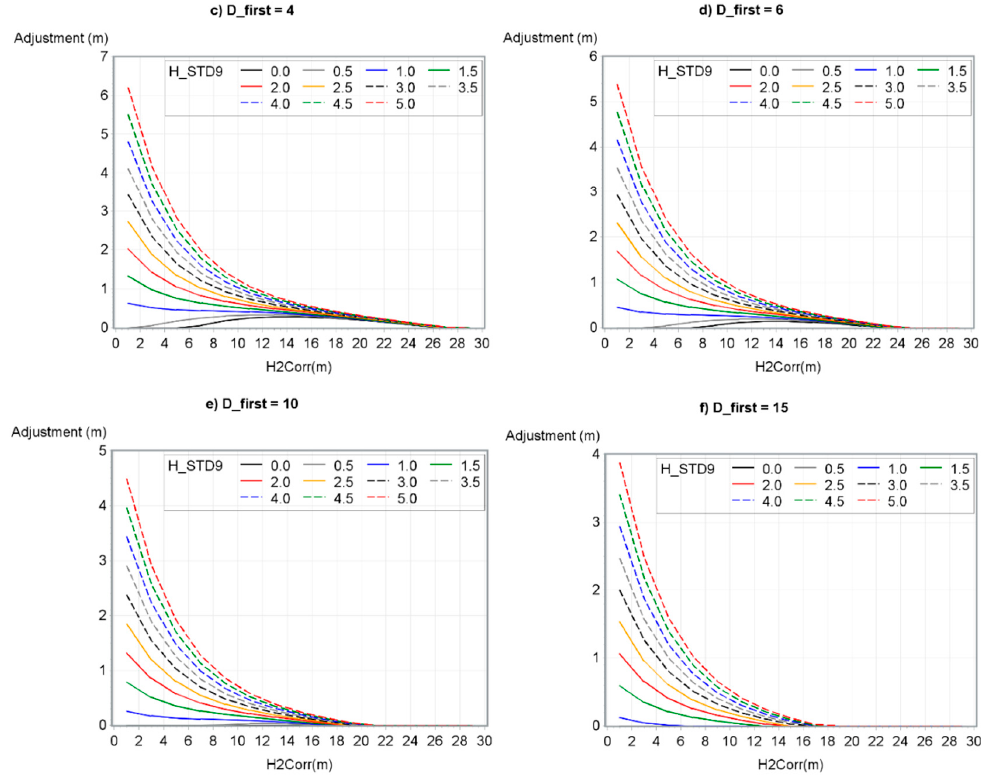
Figure 7. CHM adjustment according to H2Corr, H_STD9 and D_first. ( a ) D_first = 1, ( b ) D_first = 2, ( c ) D_first = 4, ( d ) D_first = 6, ( e ) D_first = 10 and ( f ) D_first = 15.